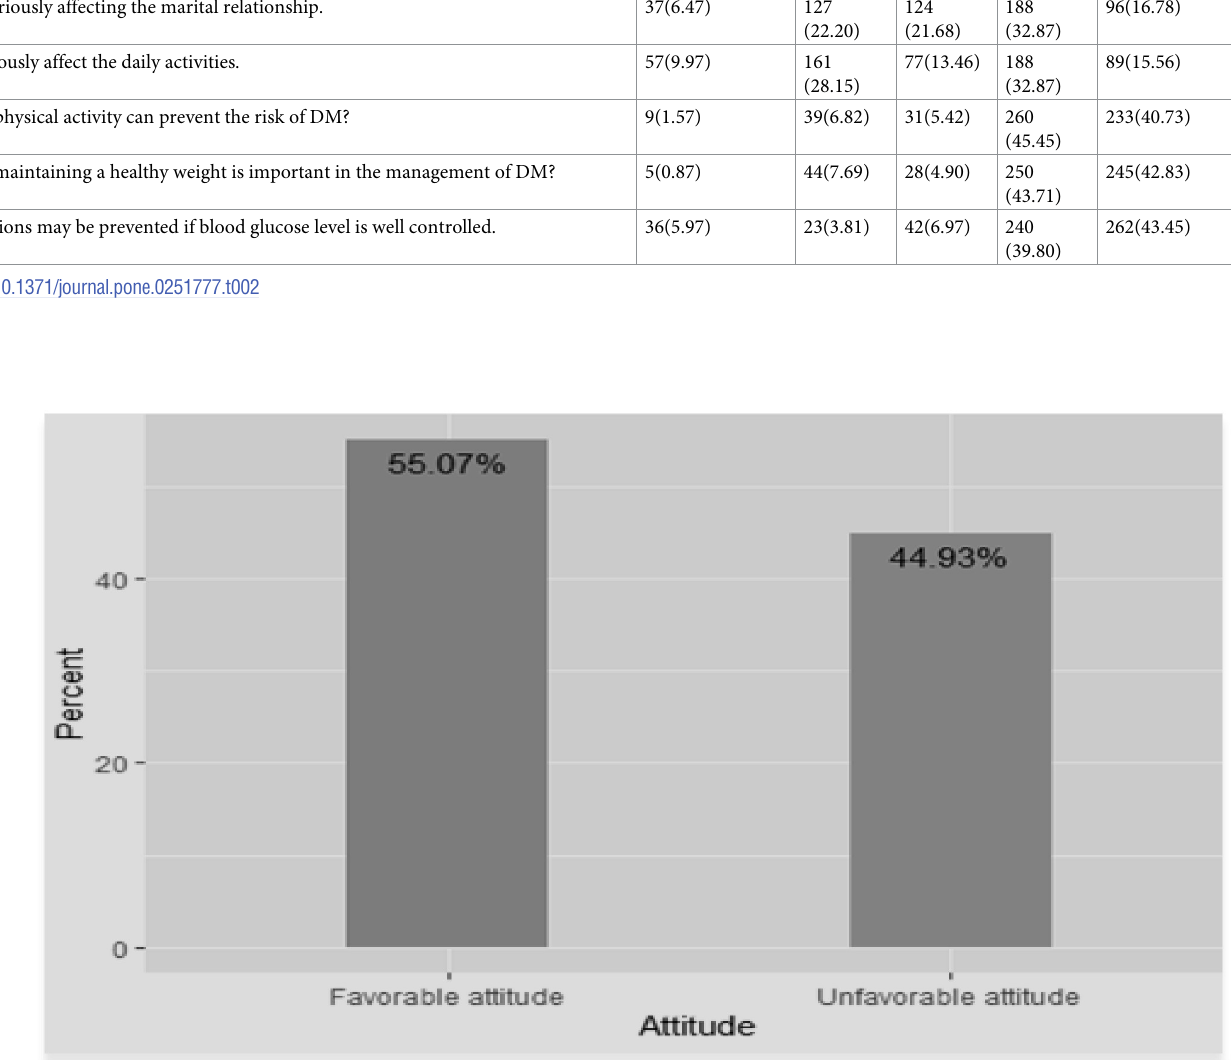
PLOS ONE | https://doi.org/10.1371/journal.pone.0251777 May 20,